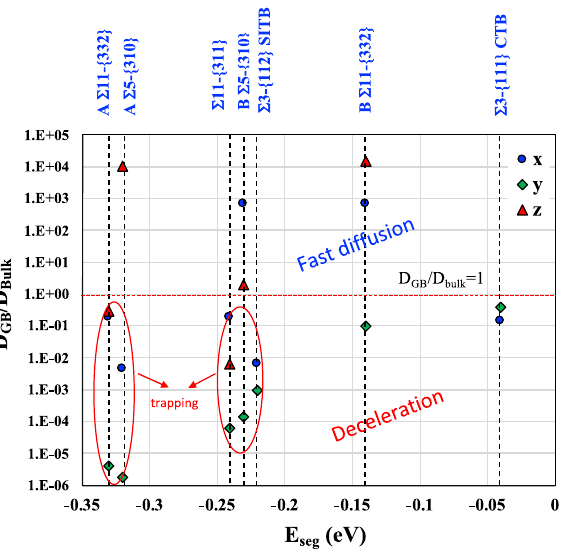
Figure 8. The diffusion coefficient ratio as a function of the hydrogen segregation energy following x, y and z directions for different